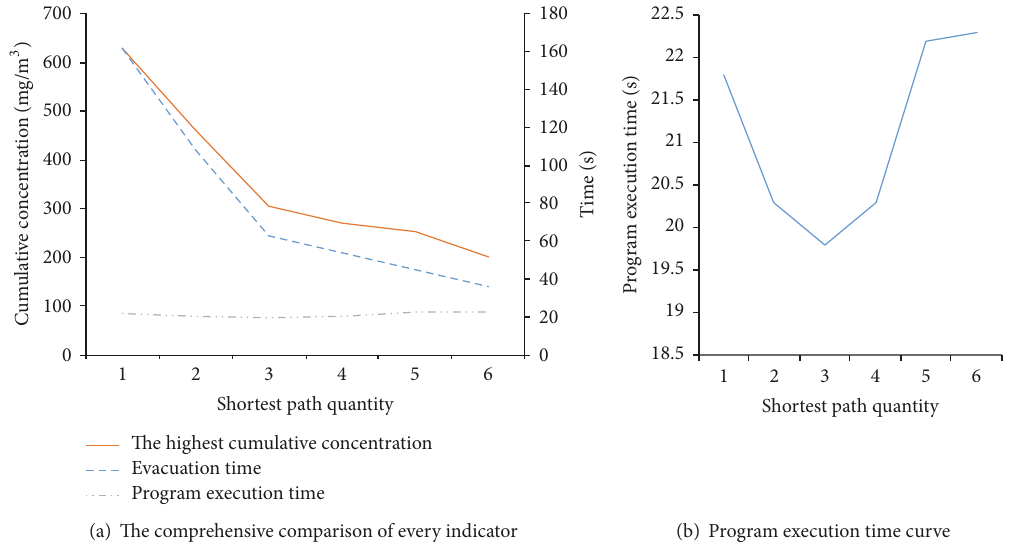
Figure 7: The results of different shortest path